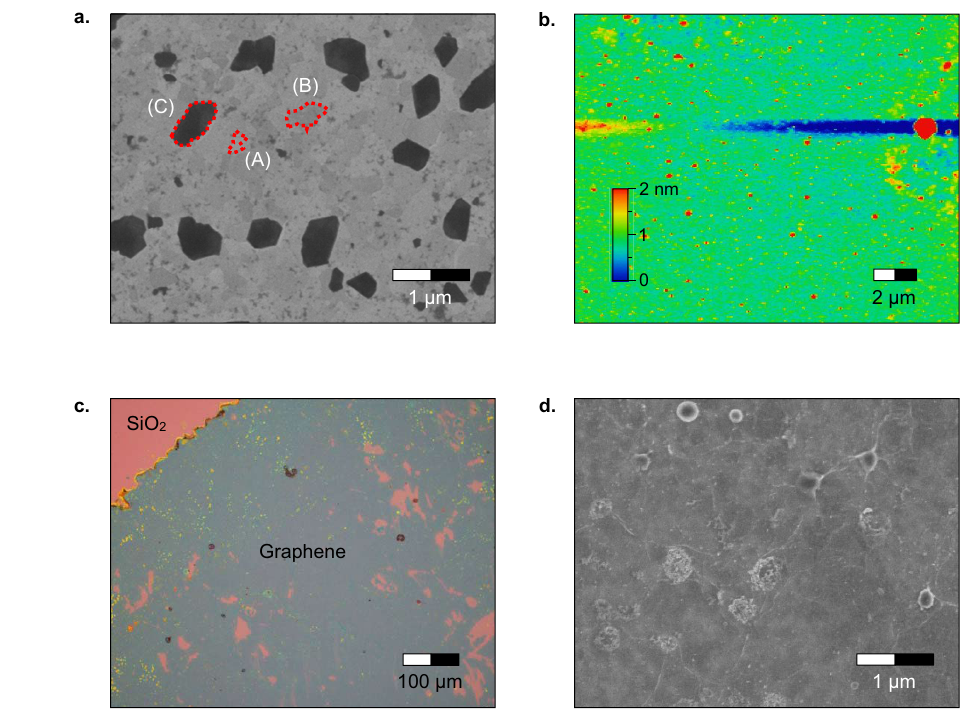
Fig. 3 Surface morphology of graphene grown on Pt thin- films. a SEM and b AFM images of a graphene film on 100 nm Pt after CVD growth. c Optical microscopy and d SEM images of graphene grown on 50 nm Pt and transferred onto an oxidized Si wafer. Note, despite using graphene grown on Pt layers with different thickness (i.e. 100 nm for a , b and 50 nm for c , d ), the catalyst thickness did not affect the quality of graphene according to Raman spectroscopy (Fig.